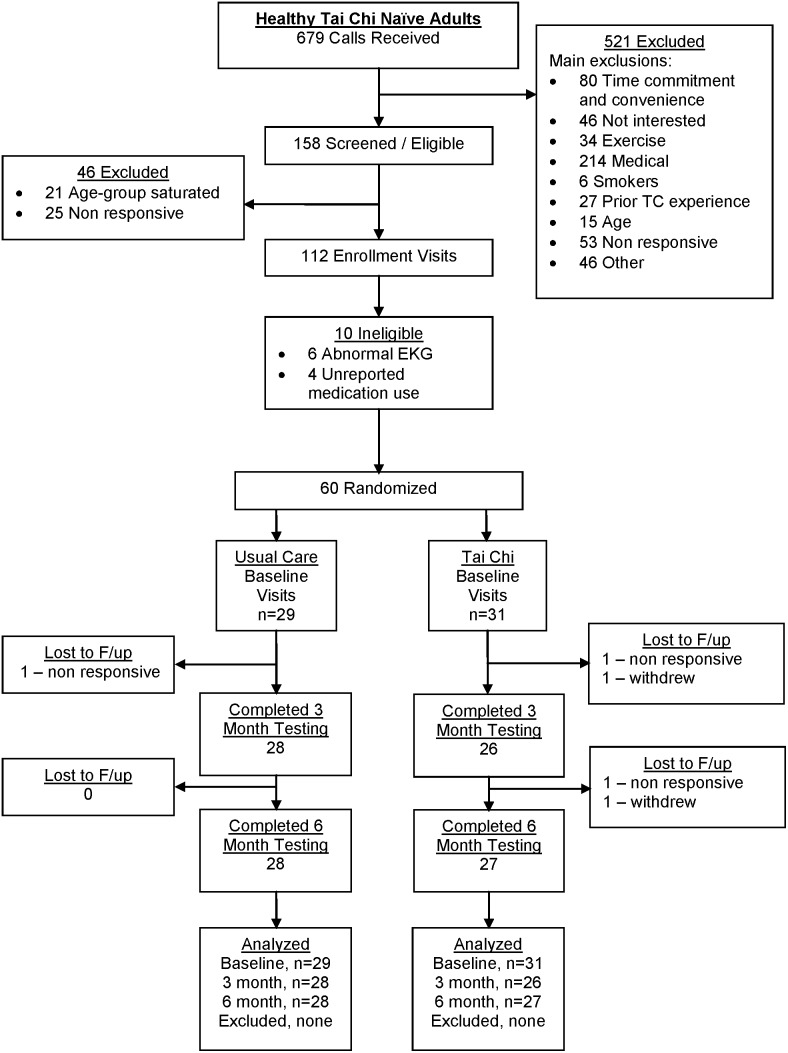
Flow of participants in randomization trial of healthy Tai Chi naïve adults.